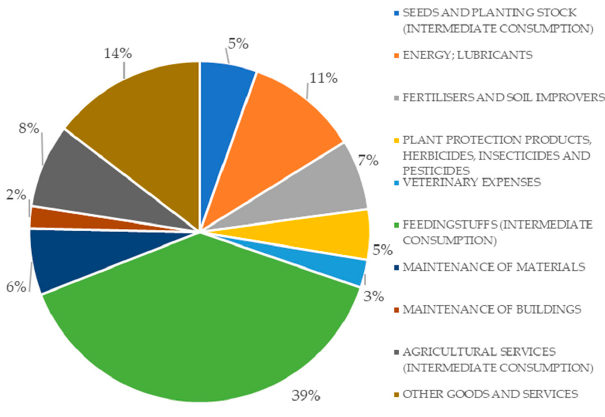
Figure 7. Total intermediate consumption structure at the level of the EU, 2020. Source: Authors’ calculation and representation, according to Eurostat (2020) data. The global performance in agriculture is not only given by the size of the result ob- tained but also by input use efficiency [70]. Within the input value structure for EU 27, the largest share is represented by feeding stuff followed by energy (Figure 8).